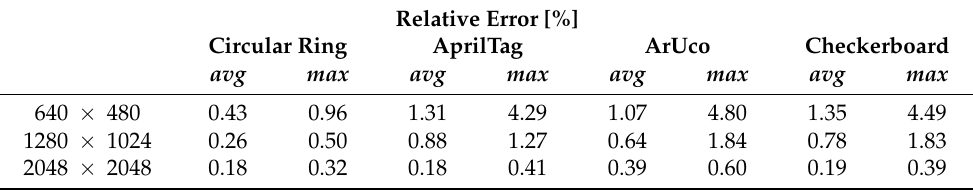
Table 6. Comparison of positioning accuracy under different resolutions.